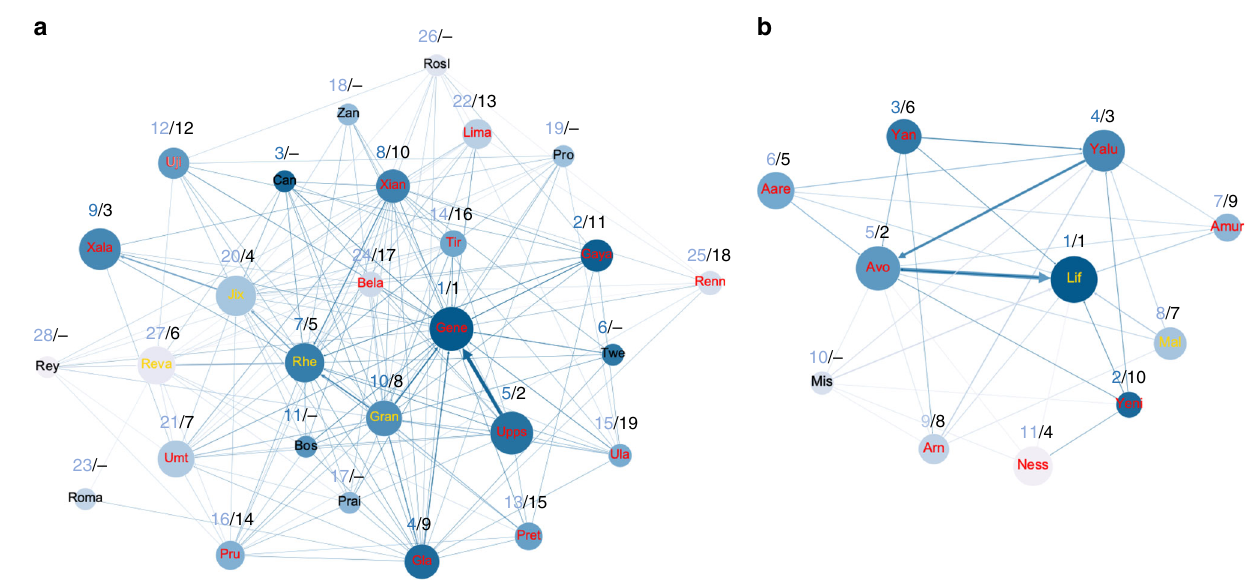
Fig. 2 Sociograms depicting transmission pathways. a Transmission pathway in Noha. b Transmission pathway in Kubu. Each node represents an individual labeled by its name (three letters code for males, four letters code for females). Individuals whose name is in red fi rst succeeded to use the lift technique; individuals whose name is in yellow fi rst succeeded to use the pull technique; individuals whose name is in black did not succeed the task. The color gradation of the nodes represents the hierarchical ranks: dark blue represents higher-ranked individuals while light blue represents lower-ranked individuals. Numbers written in blue correspond to the ranks. Size node is ranked according to the order of acquisition of the task: bigger is a node, earlier an individual learnt the task. Numbers written in black correspond to the order of acquisition of the task. The sign “ - ” signi fi es that the individual did not learn the task. Edges between individuals represent the average rate of observation of an individual by another while naive. The arrow signi fi es the direction of the observation. The thicker an edge is, the bigger the average rate of observation is.